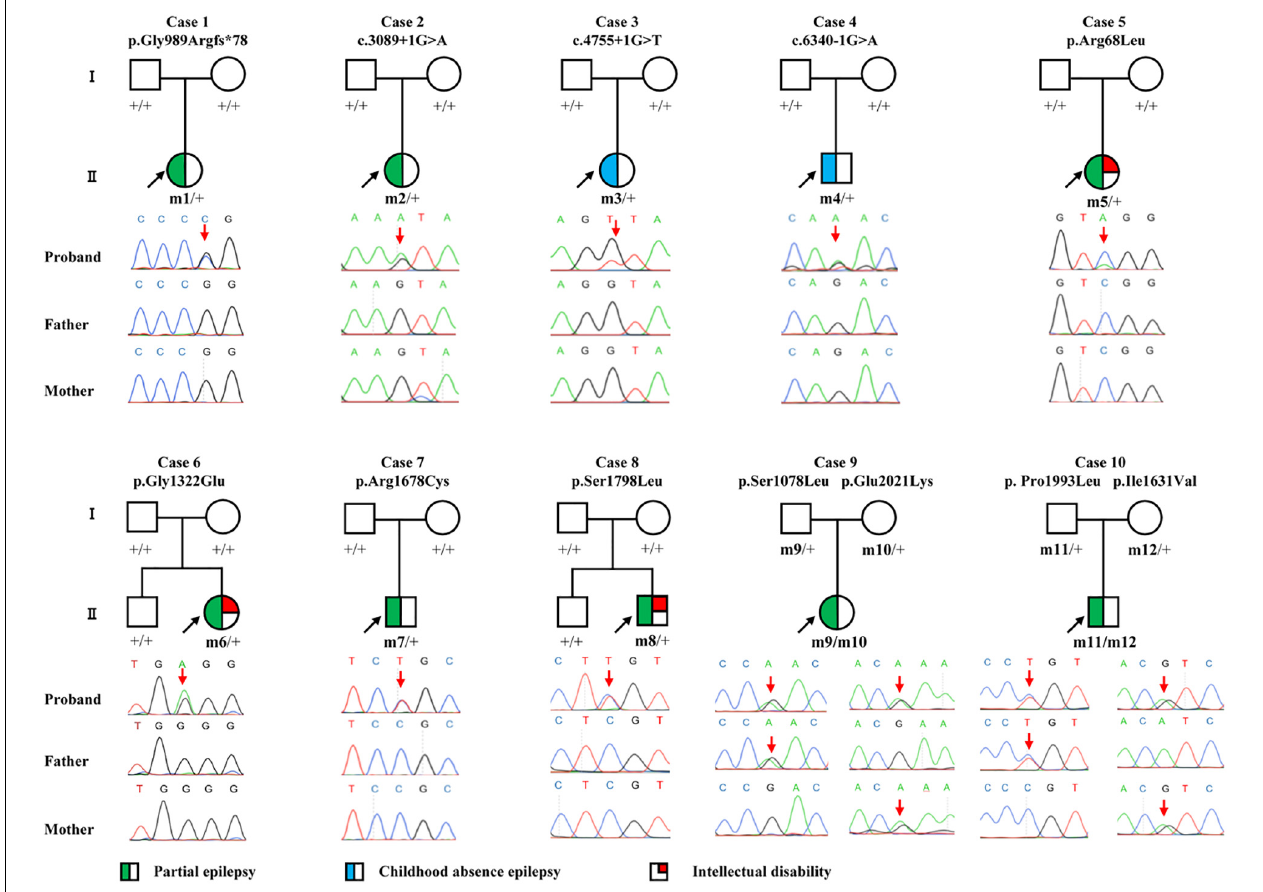
FIGURE 1 | Pedigrees and DNA sequencing chromatograms of the cases with CACNA1A mutations. Individuals with heterozygous mutation are indicated by m/ +, those with compound heterozygous mutation are indicated by m/m, and those negative for mutation are indicated by +/ +. The probands are indicated by black arrows. The positions of the mutations are indicated by red arrows. The phenotype of each case is indicated by different symbols in the figure.